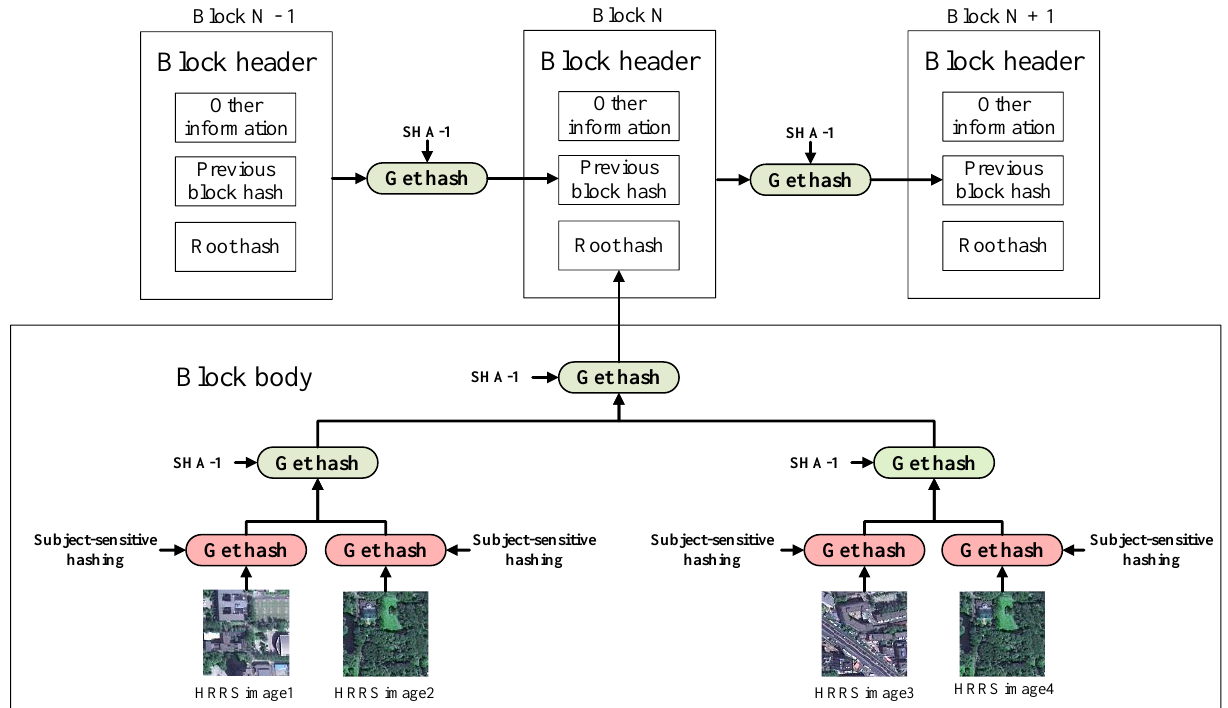
Figure 1. The structure of the improved blockchain for HRRS image.